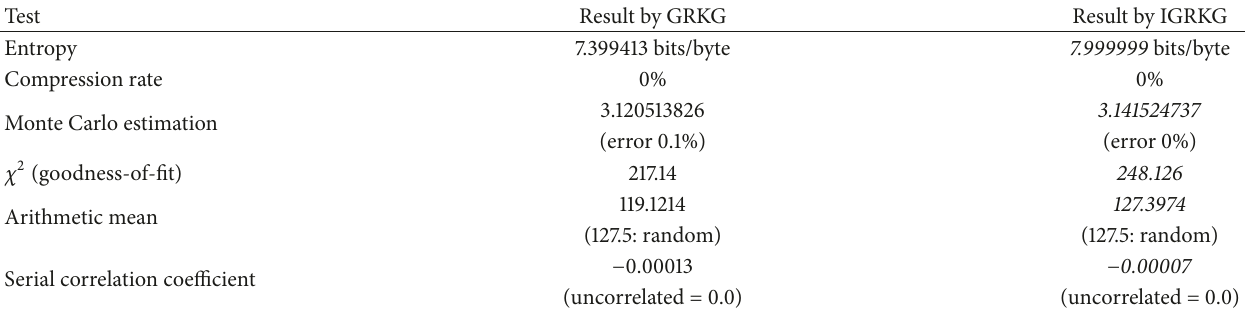
Table 11: Results obtained by ENT batteries of statistical test (GRKG versus